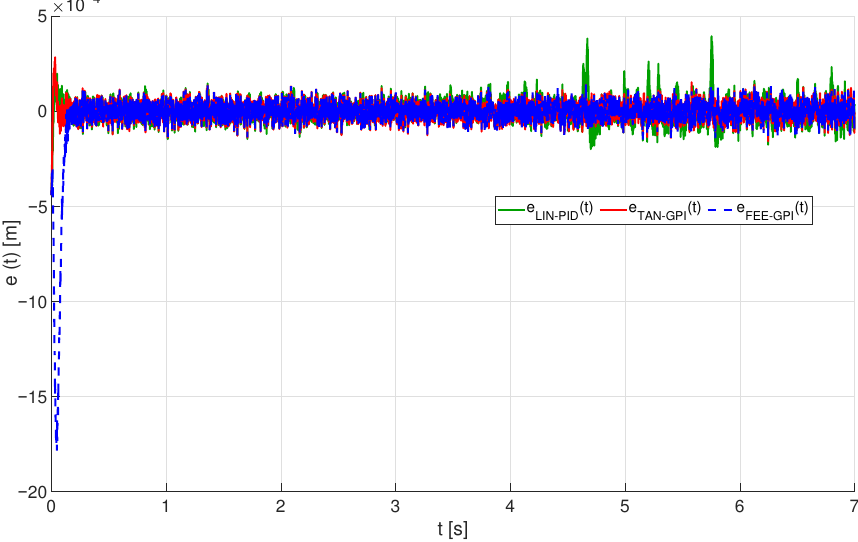
Figure 7. Evolution of tracking error trajectory of the magnetic ball, e ( t ) = y ( t ) − y ∗ ( t )[ m ] , with mea- surement noises at the control input and the output of the MLS (Test 2).